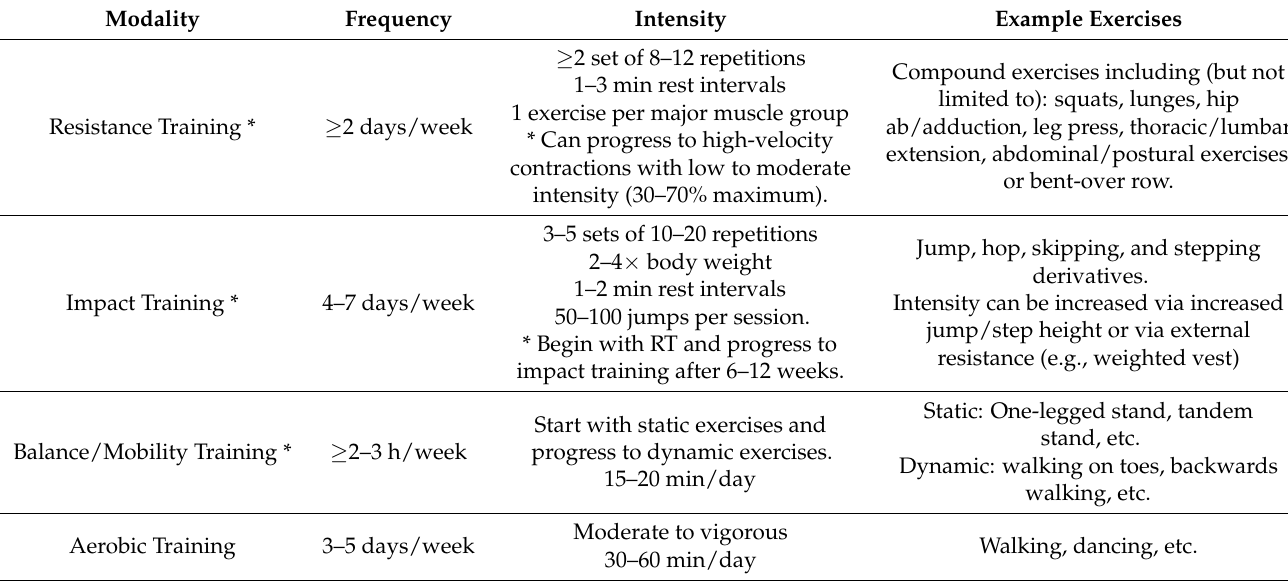
Table 1. Exercise recommendations for older adults to promote bone